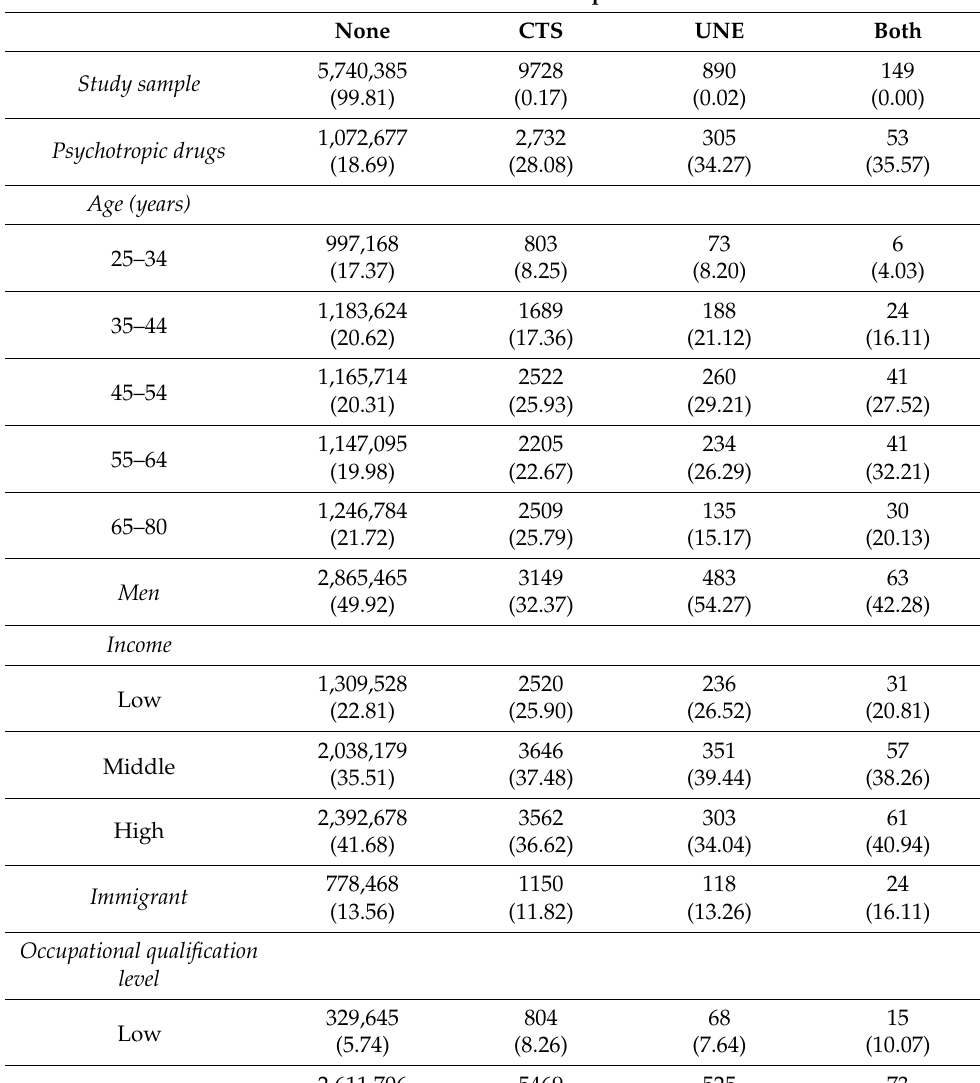
Table 1. Characteristics of the 5,751,152 individuals residing in Sweden by 2010 and included in the study sample in relation to the existence of diagnosed and surgically treated carpal tunnel syndrome (CTS), ulnar nerve entrapment (UNE), or both by use of psychotropic drugs as well as demographical and socioeconomic factors. Values are number and percentages